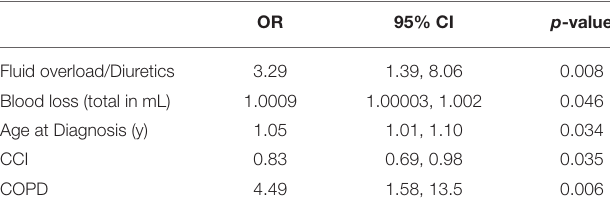
TABLE 3A | Logistic regression model summary for the outcome “Relevant Systemic Complications.”